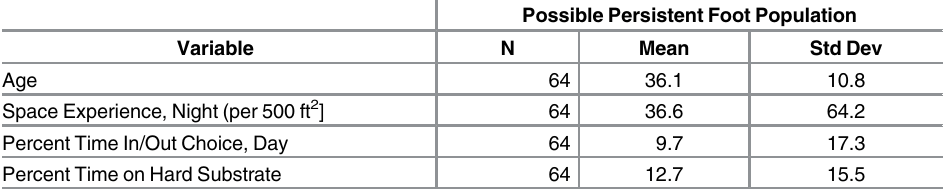
Table 8. Descriptive statistics for variables which were retained in the multi-variable regression model for the possible persistent foot score